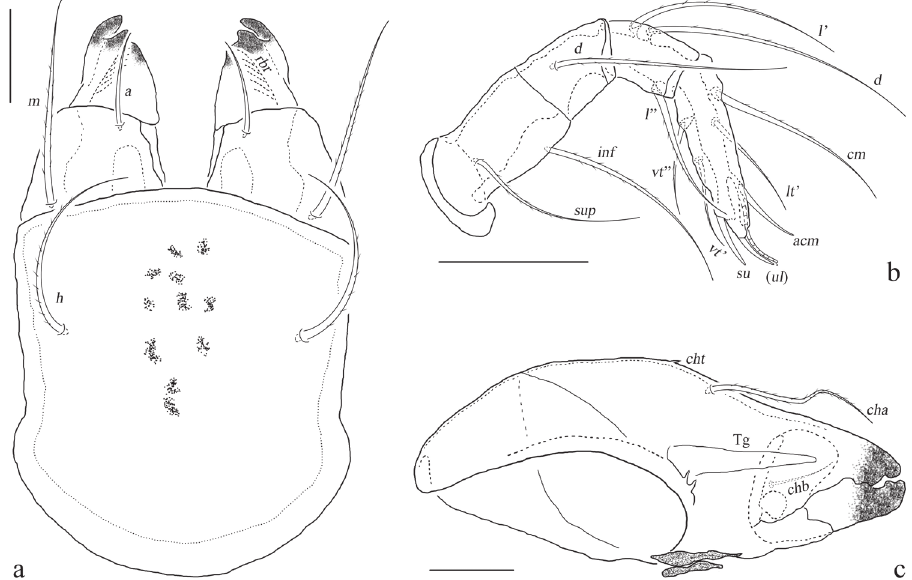
Figure 8. Eurostocepheus (Eurostocepheus) sinutus sp. nov., adult: a subcapitulum, ventral view b right palp, abaxial view c left chelicera, adaxial view. Abbreviations and notations explained in text. Scale bars: 50